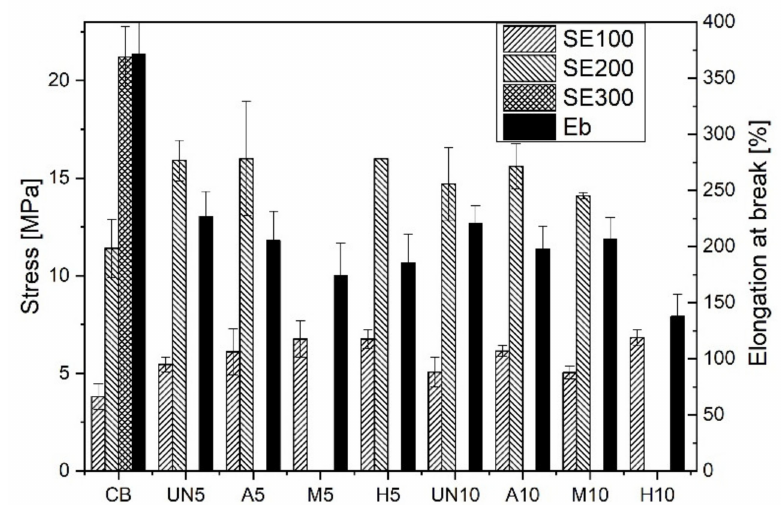
Figure 10. Mechanical properties under elongation of the rubber vulcanizates studied. Stress under elongations at 100% (SE100), 200% (SE200), 300% (SE300) and the elongation at break